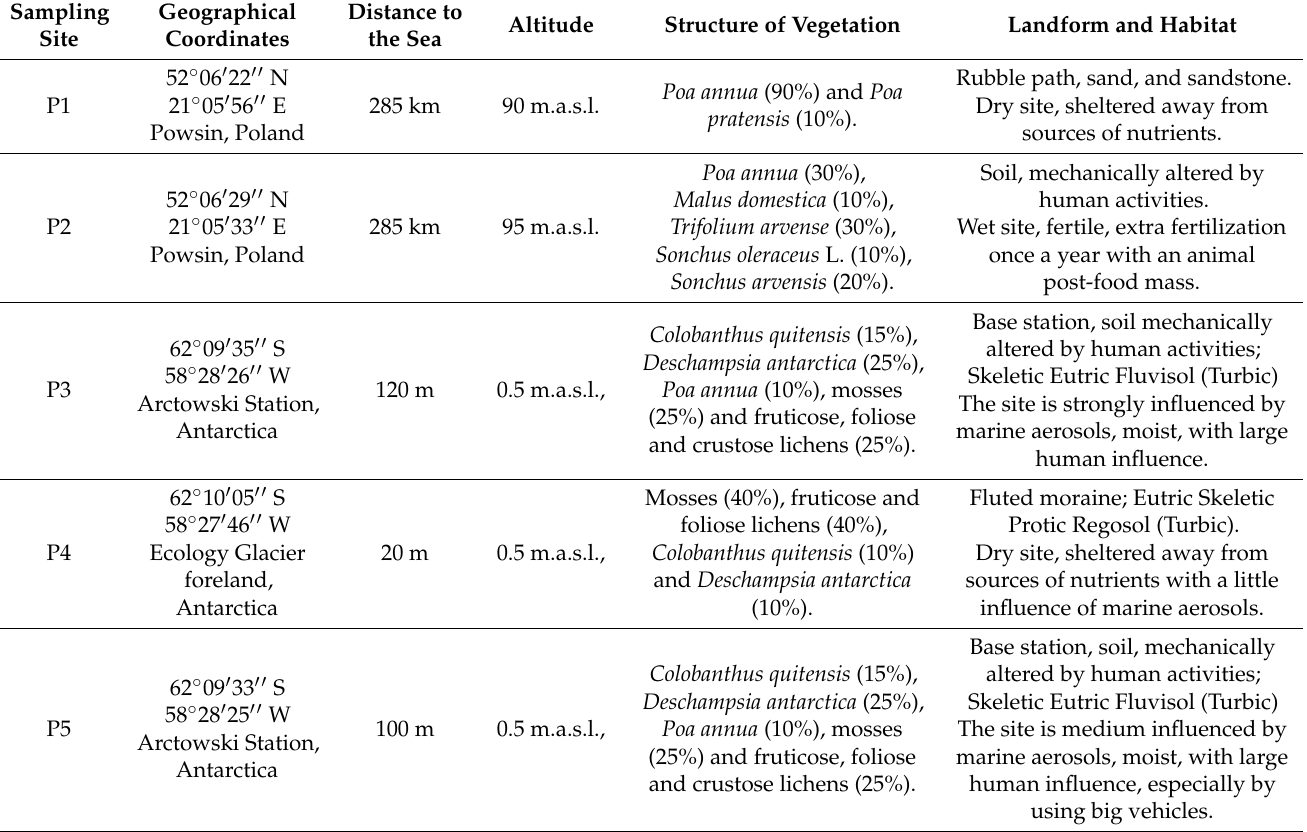
Table 1. Sampling site characteristics; m. a. s. l.—meters above sea